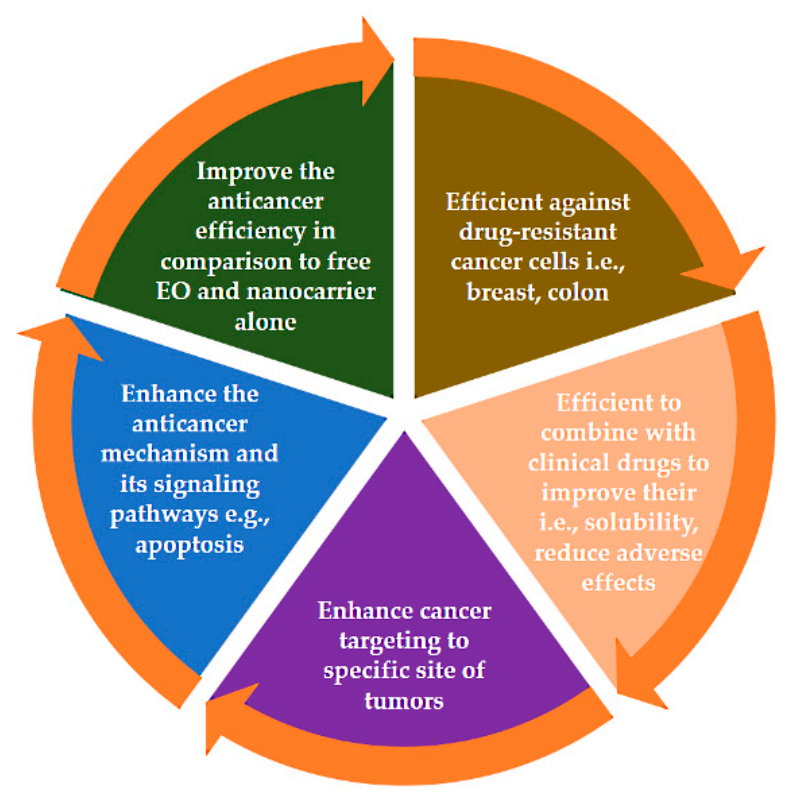
Figure 10. Schematic illustration of the impacts of nanoformulations with EOs as compared with free EOs in cancer applications.